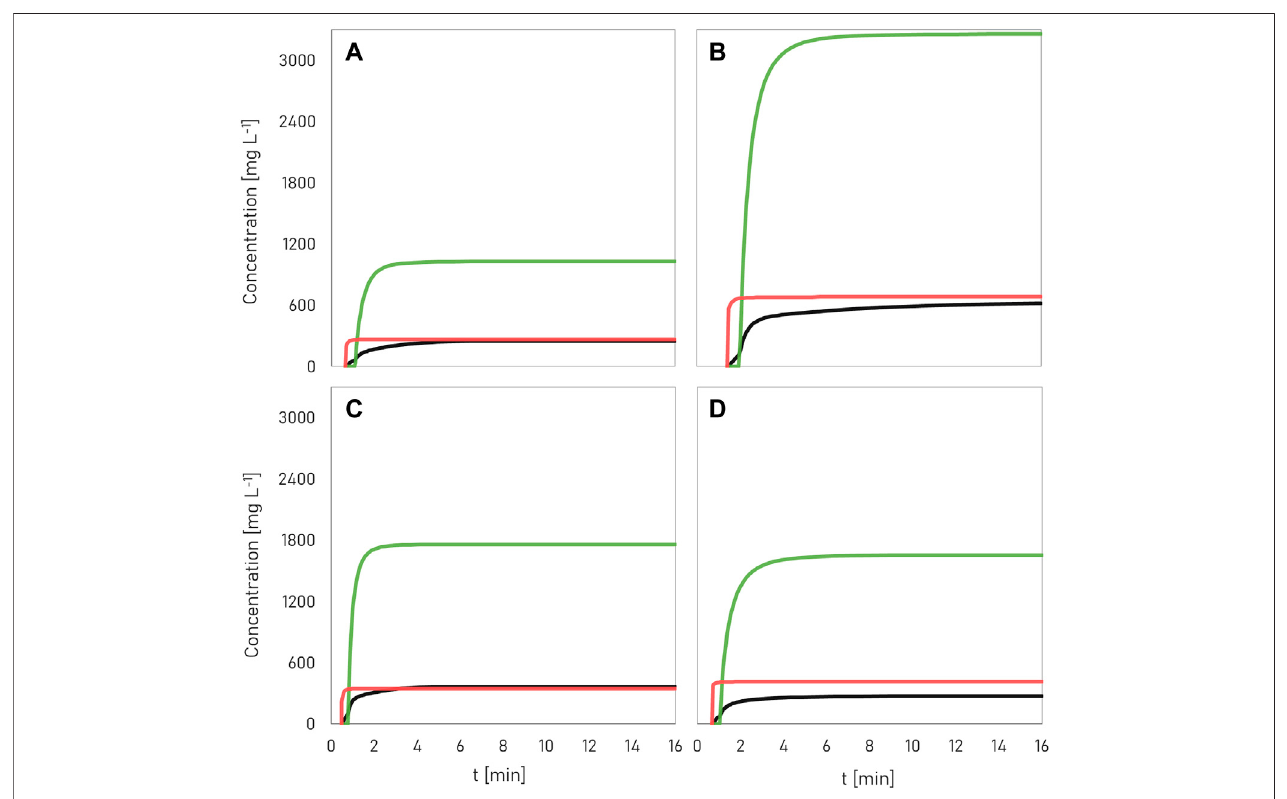
FIGURE7| KineticsofdissolutionofMg(OH) 2 (black line)andformationofhydroxyapatite(redline)andstruvite(greenline)infreshurinedosedwith2 gMgOL − 1 at 25 ° C. Four different urine compositions were used: FU 1 (A) , FU 2 (B) , FU 3 (C) and FU 4 (D) .